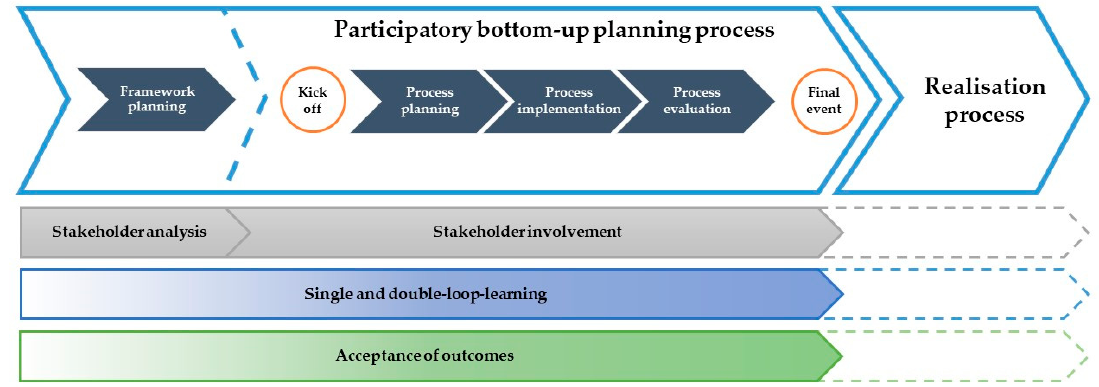
Figure 2. Participation design for establishing wastewater as a renewable energy source (based on [63,66]).